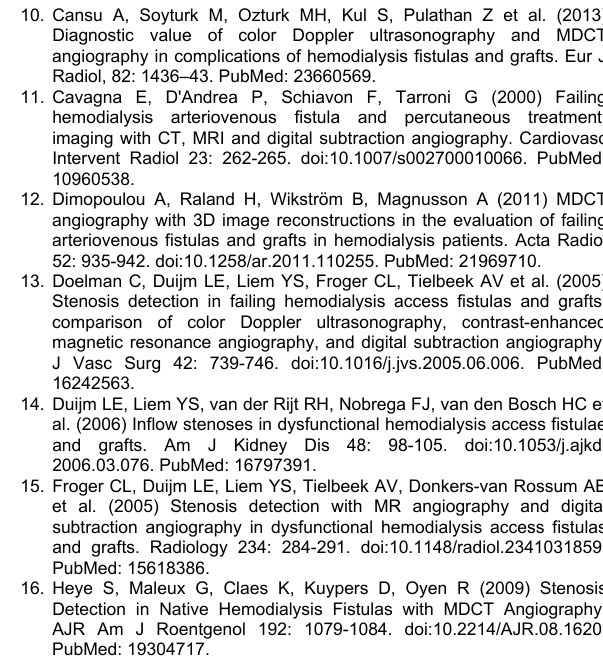
Table S1. Summary of details about the data acquisitions of CTA and